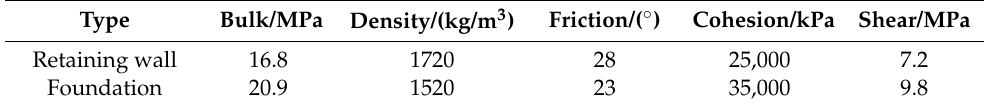
Table 1. Mechanical parameters of foundation and wall.